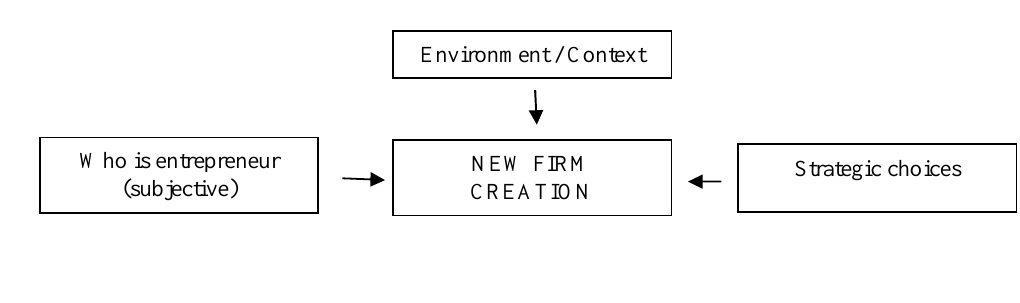
Figure 1: New Firm Creation